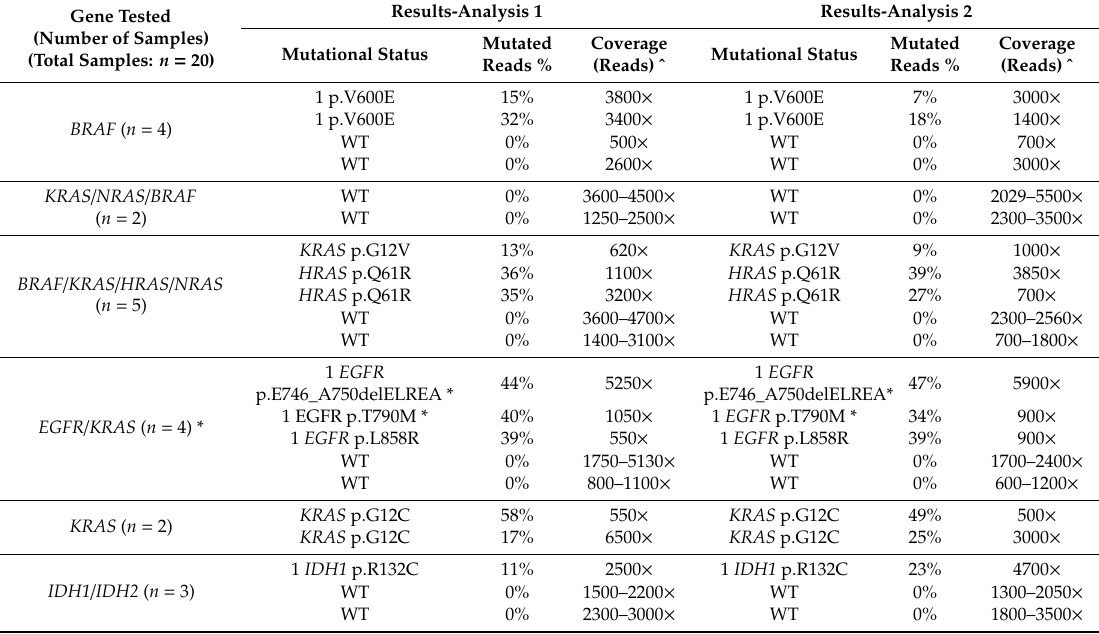
Table 3. Custom-designed multi-gene panel analytical validation of 20 samples tested in two di ff erent runs using the same MiSeq sequencing